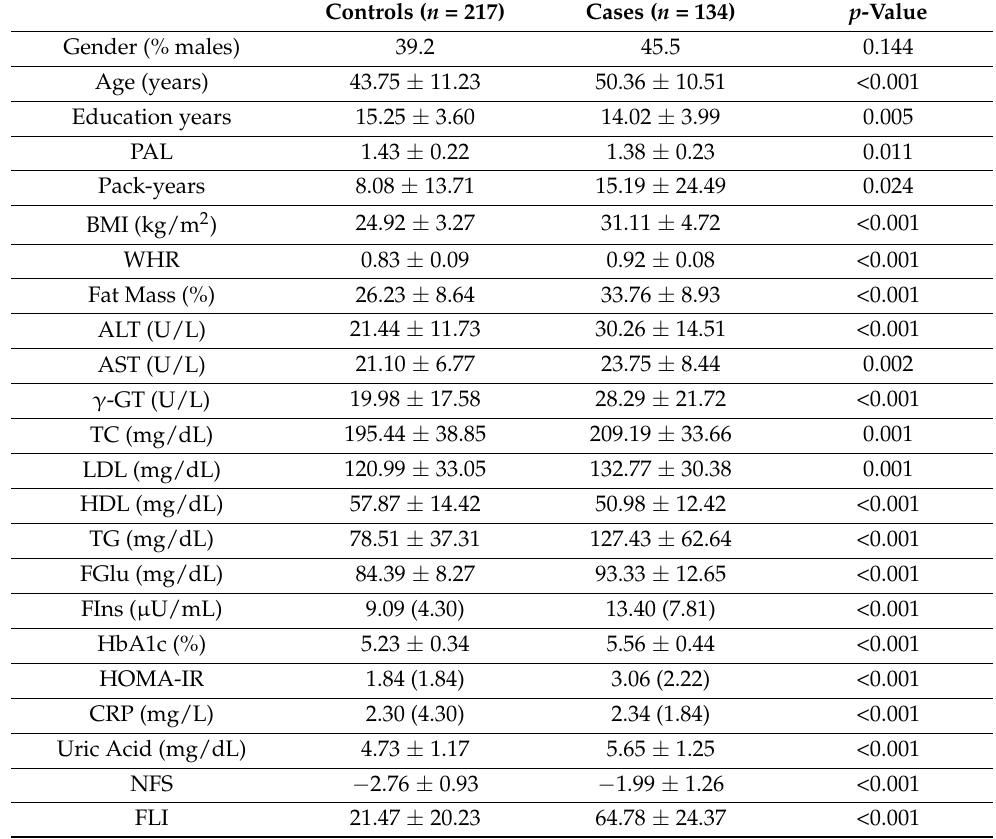
Table 1. Demographic, anthropometric, and clinical characteristics of the study population. All individuals were of Caucasian